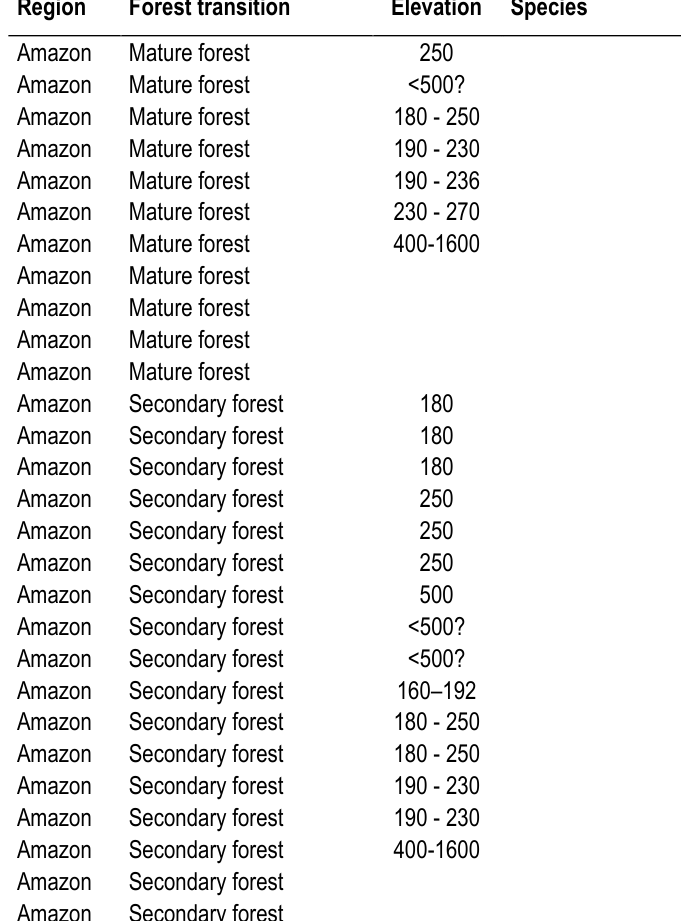
Table A1 . Above ground (AG) and below ground (BG) carbon stock reported in different forest types and regions.